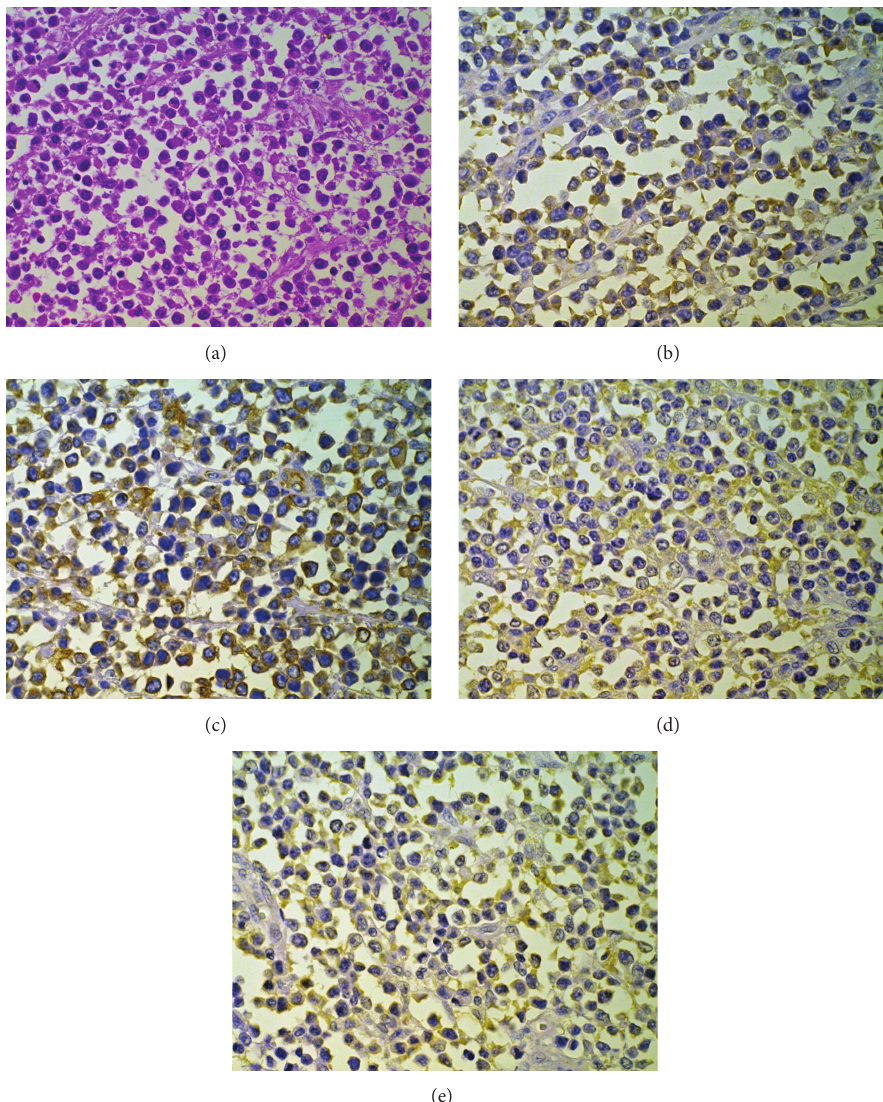
Figure 2: Photomicrographs revealed various tumor properties. (a) The tumor contained small hyperchromatic cells mixed with a finely fibrillar stroma (hematoxylin and eosin). The tumor stains positively for (b) neuron-specific enolase, (c) vimentin, (d) synaptophysin, and (e) S-100 protein. All presented images were reduced from × 400 magnification